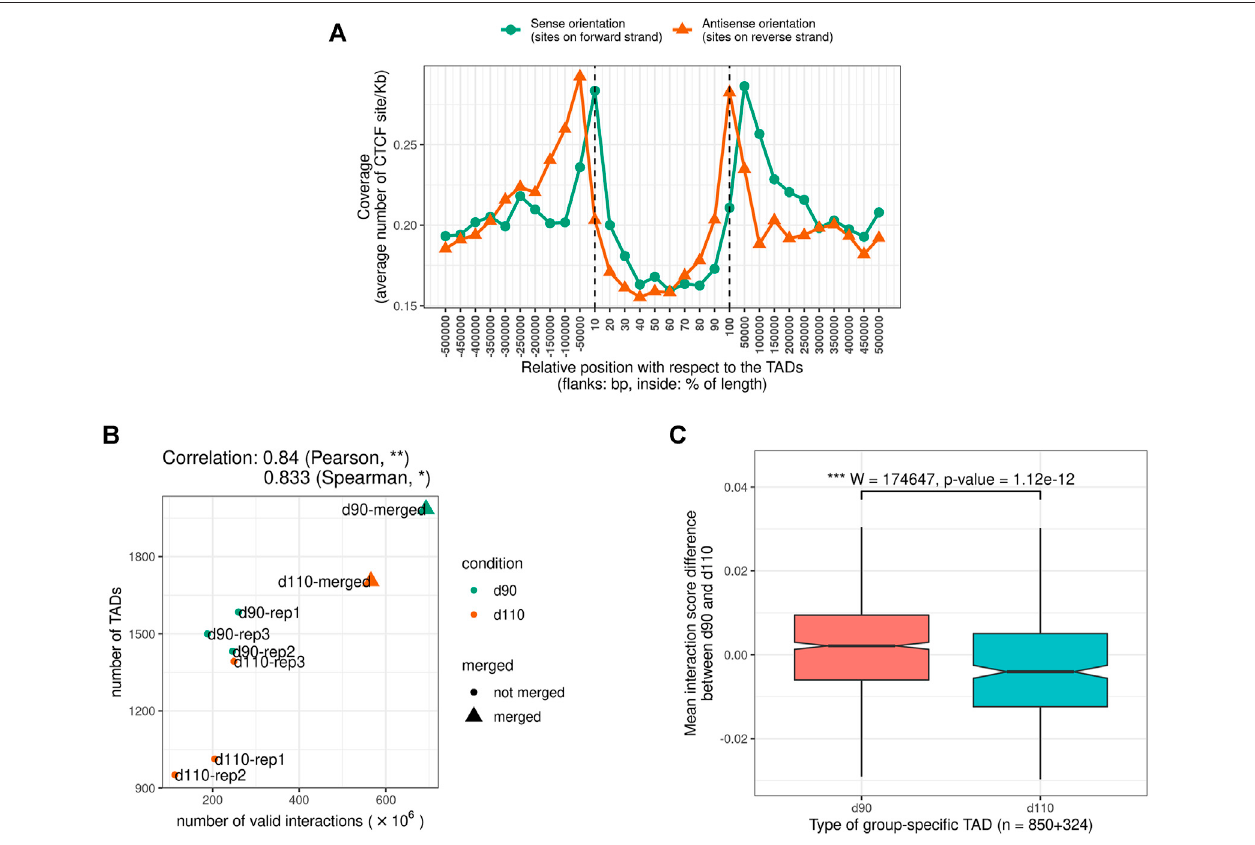
FIGURE 3 | Characteristics of Topologically Associating Domains (TADs) (A) The genomic distribution of CTCF binding sites over TAD regions shows an accumulationofsitesattheTADboundariesintheexpectedinwardsorientation,meaningforwardandreversesitesrespectivelyatthebeginningandattheendofTADs. Flanking TADs explain the shifted peaks corresponding to sites in the outwards orientation (B) Correlation between Hi-C matrix density (number of interactions) and numberofpredictedTADs (C) DistributionsofInteractionScoreDifferencesbetween90and110 daysofgestationforboundariesofd90-andd110-speci fi